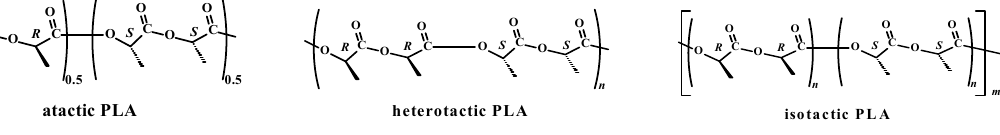
Scheme 2. The stereostructures of PLA.